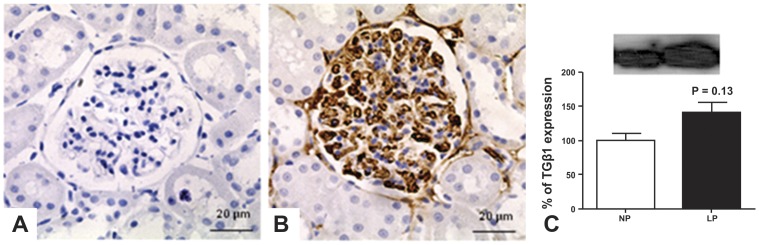
We found an intensive rise of the TGF-β1 expression in LP (B, from 5 rats) compared to NP glomeruli (A, from 5 rats).By western blot from total renal tissue extract we also found enhancement in the expression of this protein in LP offspring (C).